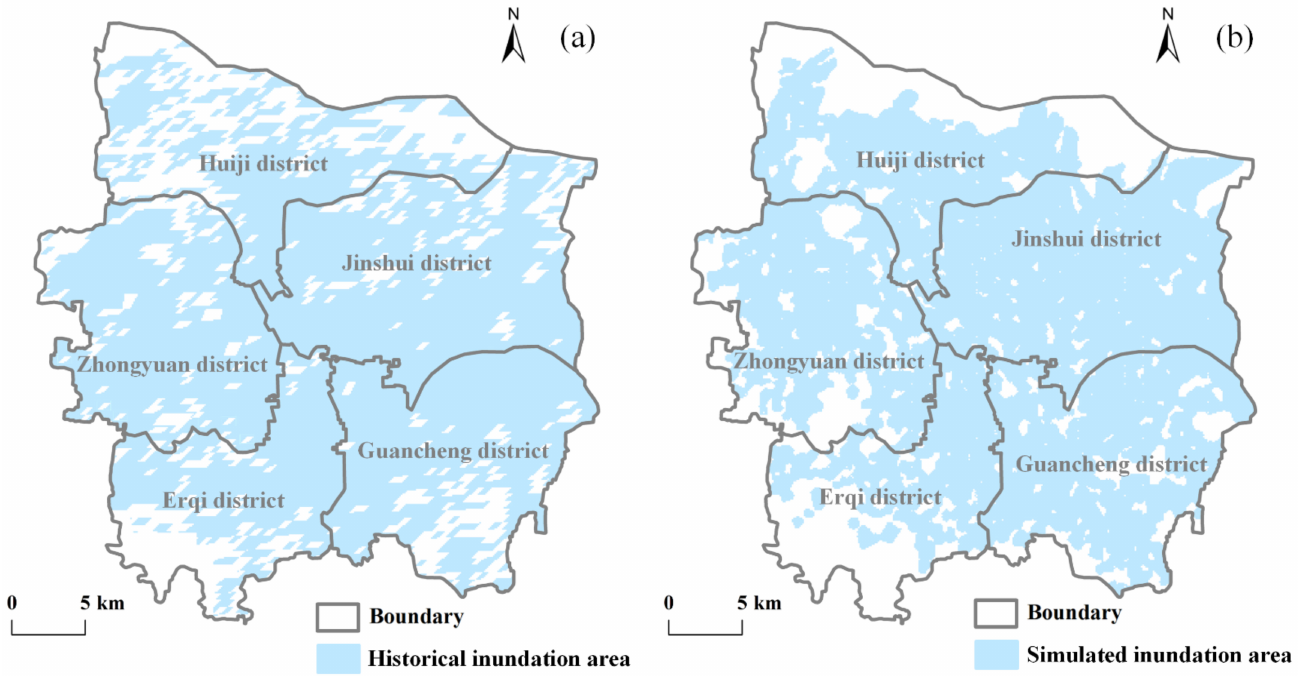
Figure 6. Distribution of ( a ) historical inundation area, and ( b ) simulated inundation